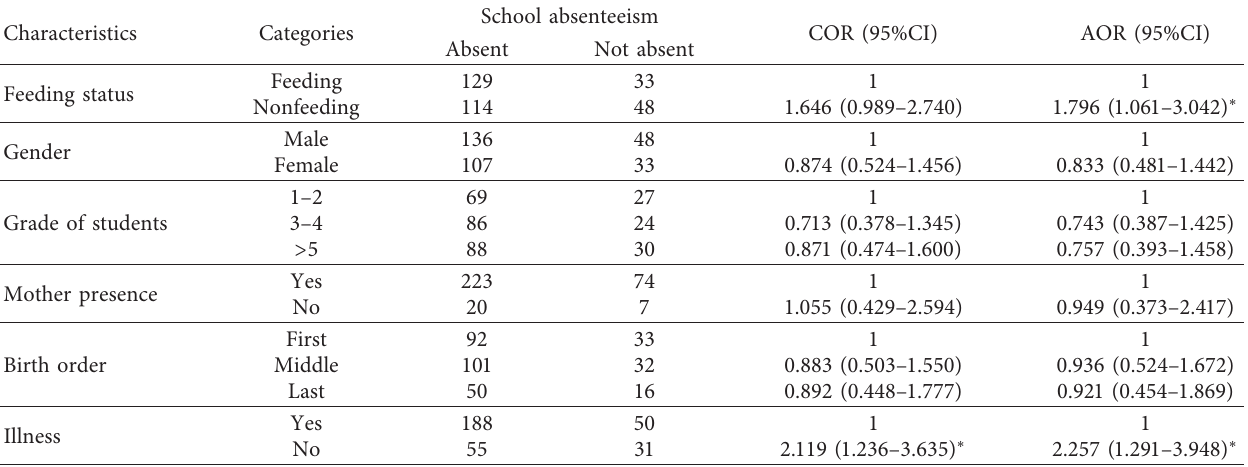
Table 5: Factors associated with school absenteeism at selected primary schools in Addis Ababa, Ethiopia, May 2018.